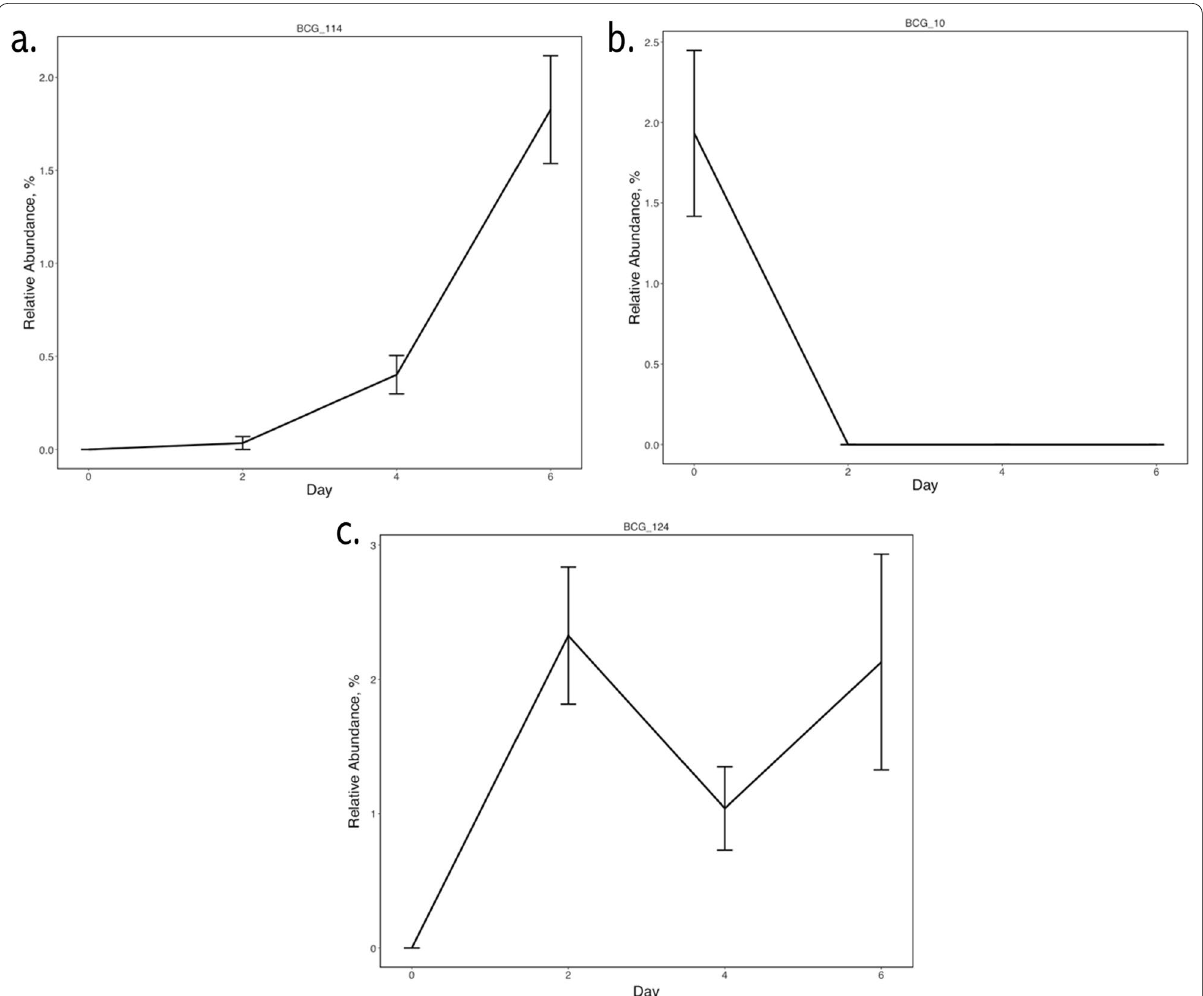
Fig. 3 Differentially abundant bacterial co‑abundance groups (BCG) following transitions between cool‑season and warm‑season grass. Relative abundances are shown across days within transitions between a cool‑season grass to warm‑season grass pasture and b warm‑season to cool‑season grass within the crabgrass integrated rotational grazing system and the c warm‑season to cool‑season grass transition within the bermudagrass integrated rotational grazing system. The BCG were identified as differentially abundant using Analysis of Composition of Microbes (ANCOM) in Qiime 2 (v.2020.8) (W ≥